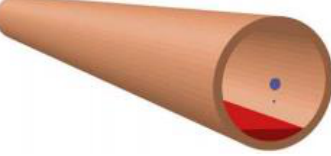
Figure 16. Solid-state model of a rotary kiln (according to the authors’ data).